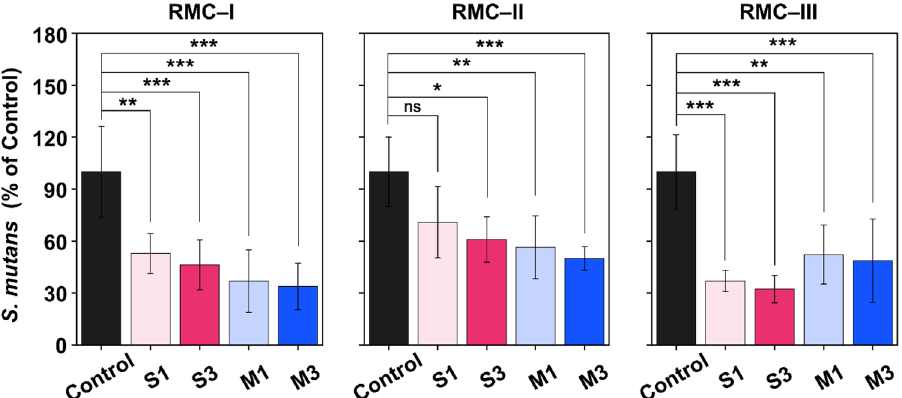
Figure 3. Optical density (OD 450 ) readings derived from S. mutans attached on the surfaces of the RMC-I, II, and III. A varying number of asterisks indicate significant differences by post-hoc Tukey’s test (* P < 0.05, ** P < 0.01, and *** P <